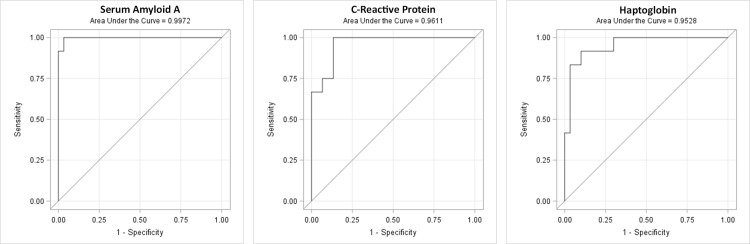
Receiver operating characteristic curves.ROC curves for serum amyloid A, C-reactive protein, and haptoglobin. The above acute phase reactants had areas under the curve of >95% for prediction of EOS.